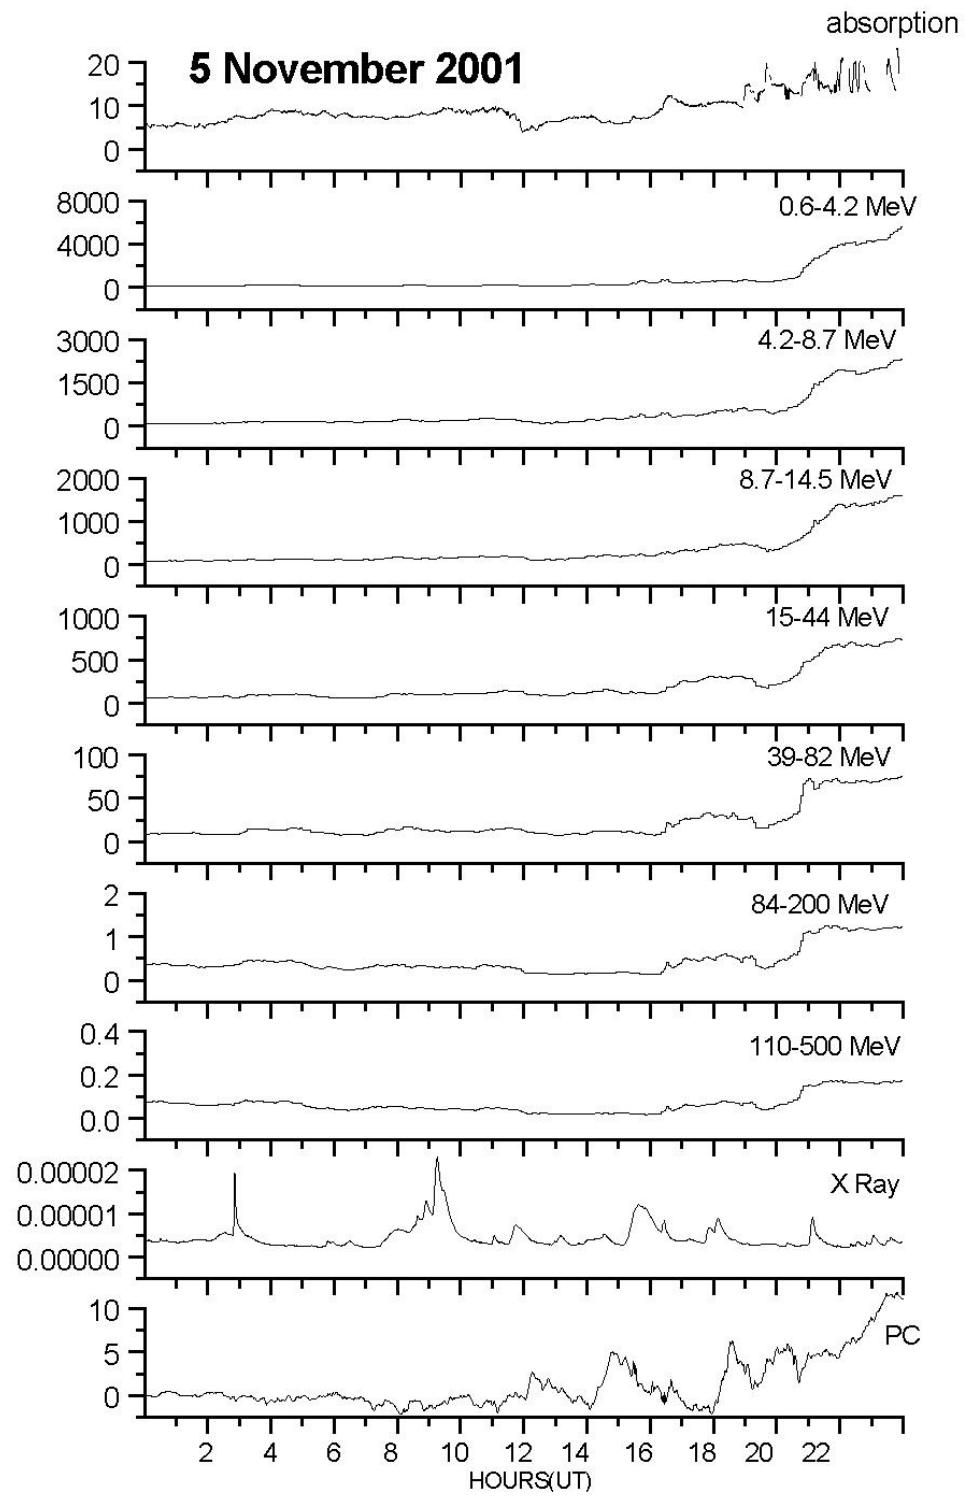
Fig. 3. As Fig. 1, but for 5